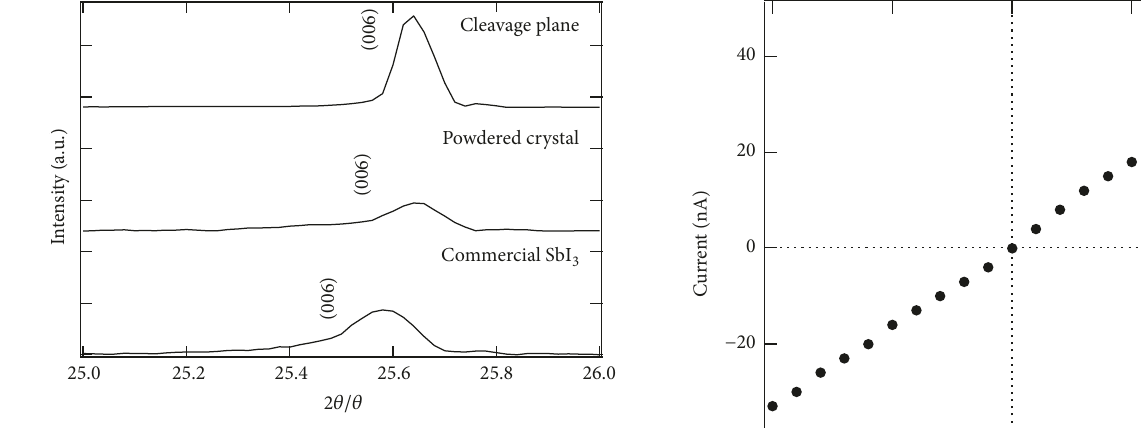
no full-energy peaks corresponding to 5.48 MeV of